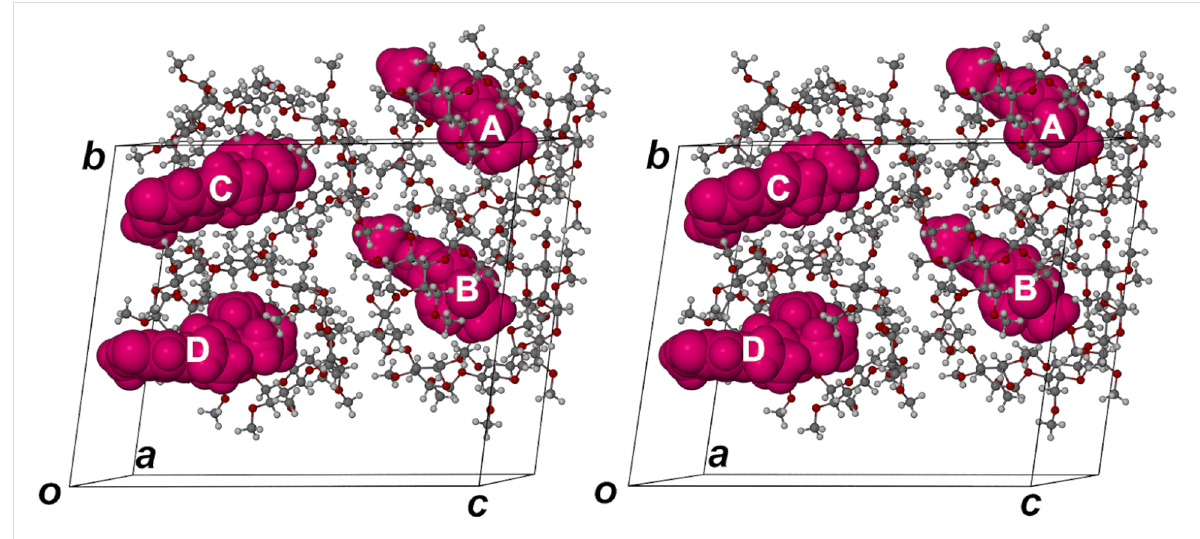
Figure 3: Stereoview of the asymmetric unit in the crystal of the inclusion complex TRIMEB•2ME, with the host TRIMEB molecules drawn in ball-and- stick representation and the guest 2ME molecules (magenta) in space-filling mode.